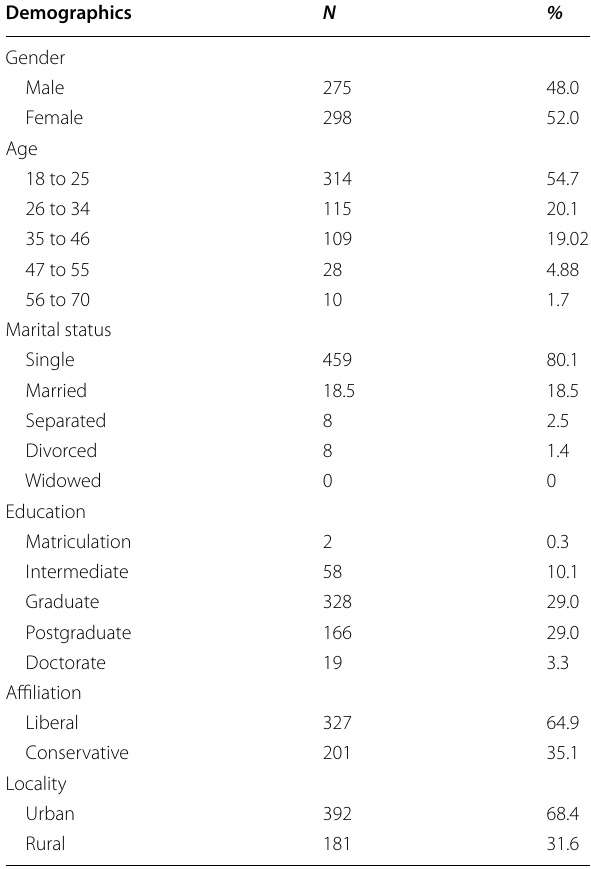
Table 1 Sociodemographic characteristics of participants at baseline